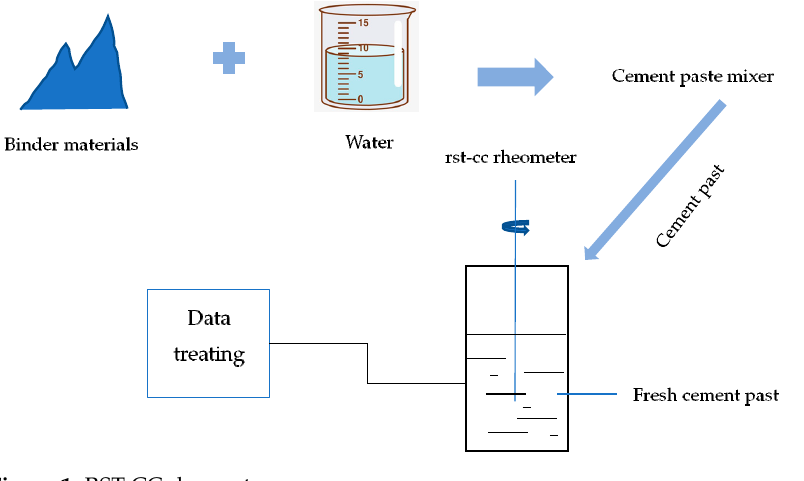
Figure 1. RST-CC rheometer.